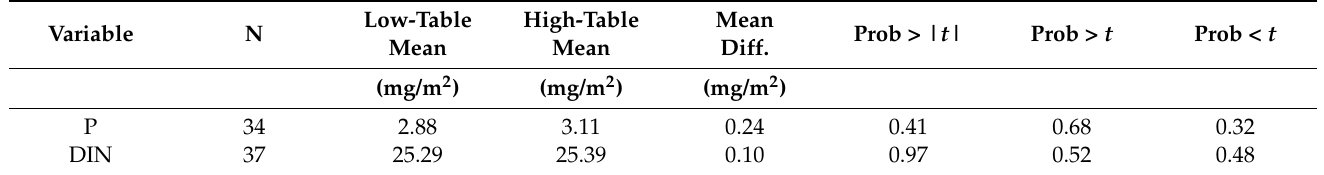
Table 1. Student t -test results comparing measurements from the collectors with high tables and low tables.